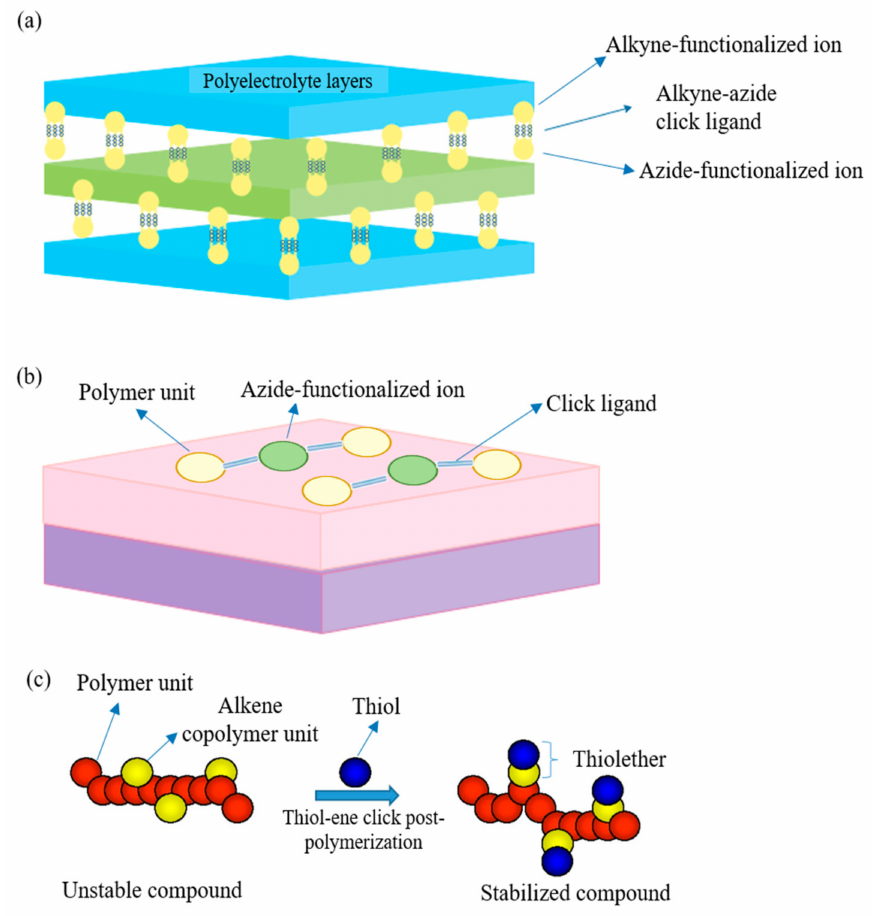
Figure 7. Click reaction in: ( a ) layer-by-layer (lbl) assembly technique; ( b ) nanofiller modification; and ( c ) post-polymerization